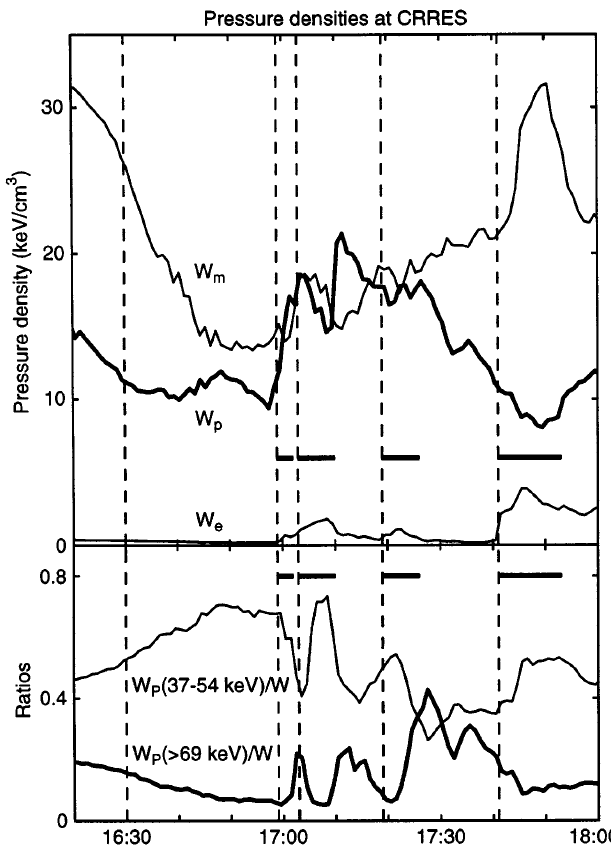
Fig. 6. Upper panel. Energy densities of the magnetic field (cid:133) W m (cid:134) , perpendicular electrons (cid:133) W e (cid:134) and protons (cid:133) W p (cid:134) during the growth and active phases on February 9, 1991. Lower panel. Relative contribution of the 37–54 keV protons and the > 69 keV protons to total proton energy density